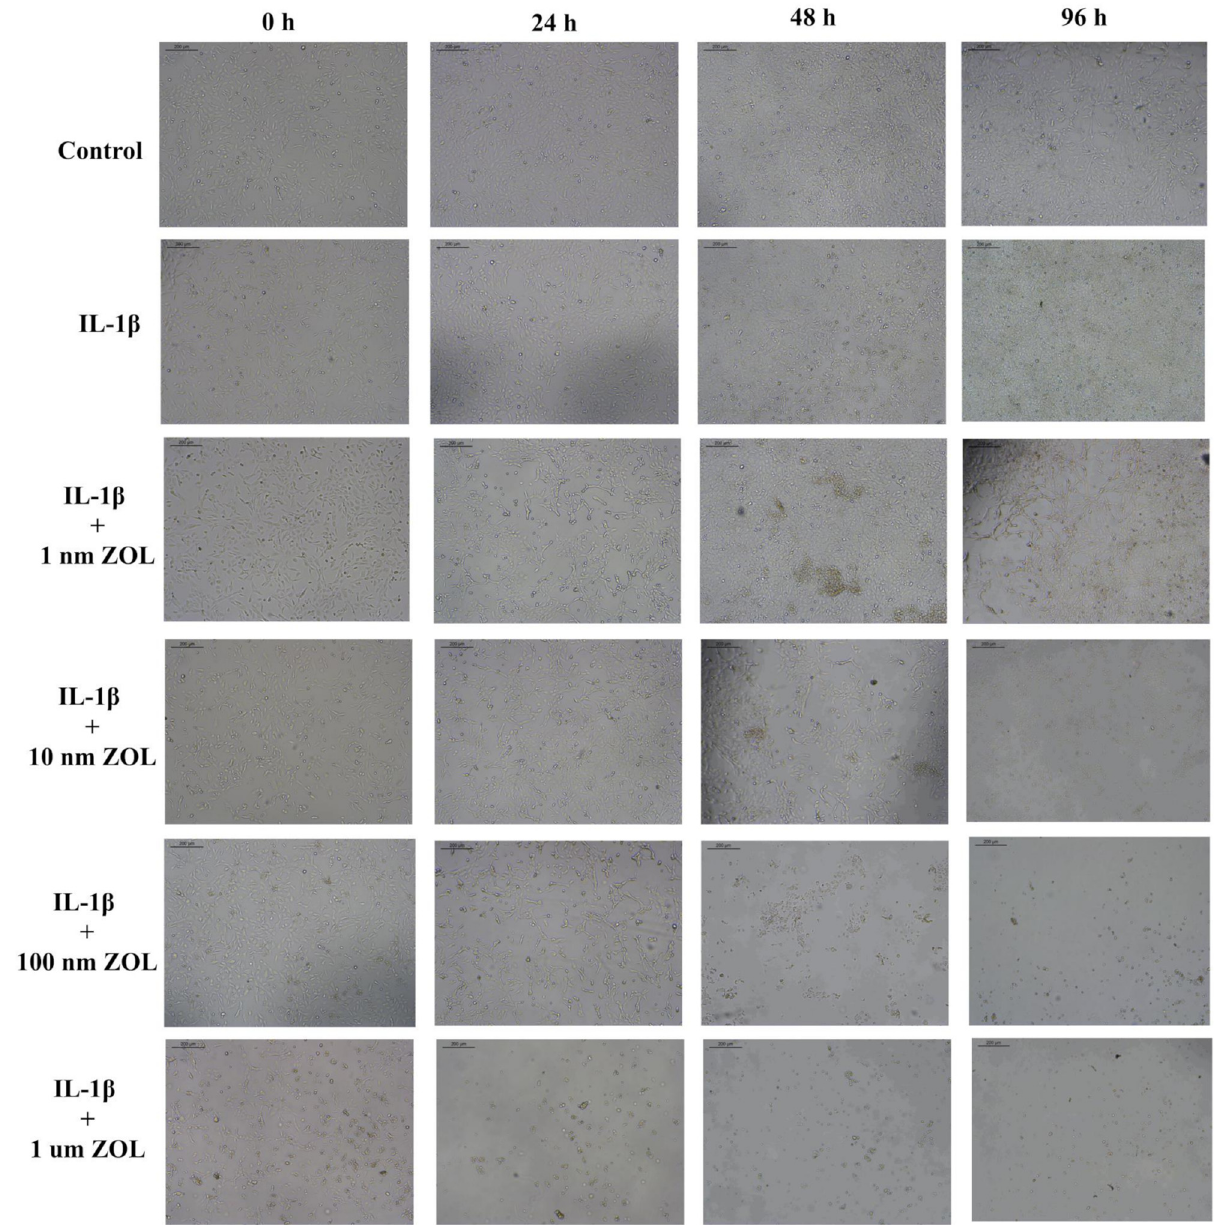
Figure 2: The morphological and abundance changes of TMJOA chondrocytes treated with di ff erent concentrations and times of ZOL ( scale bar = 200 µm )